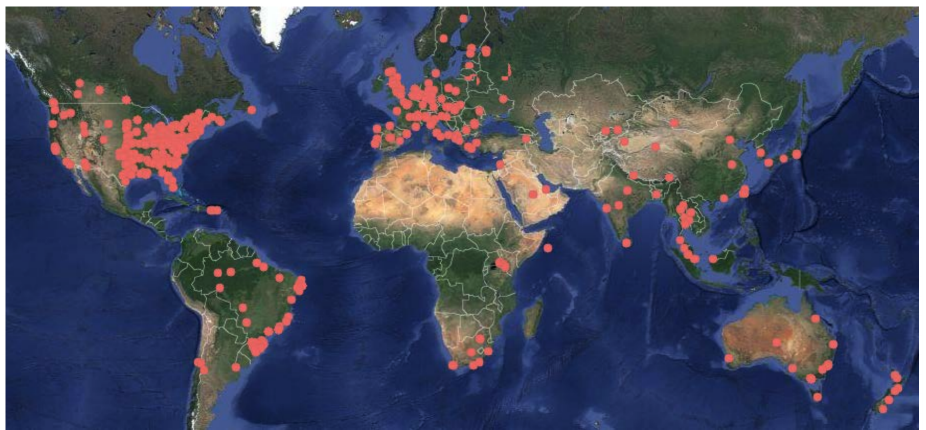
Figure 2: perfSONAR public network; there are currently around 2000 known deployed Figure 1: (a) PerfSONAR architecture (b) One-way Delay Measurement Protocol (OWAMP). instances with likely an equal number of private deployments, WLCG network is one of the biggest private deployments with over 250 instances connected to LHCOPN /